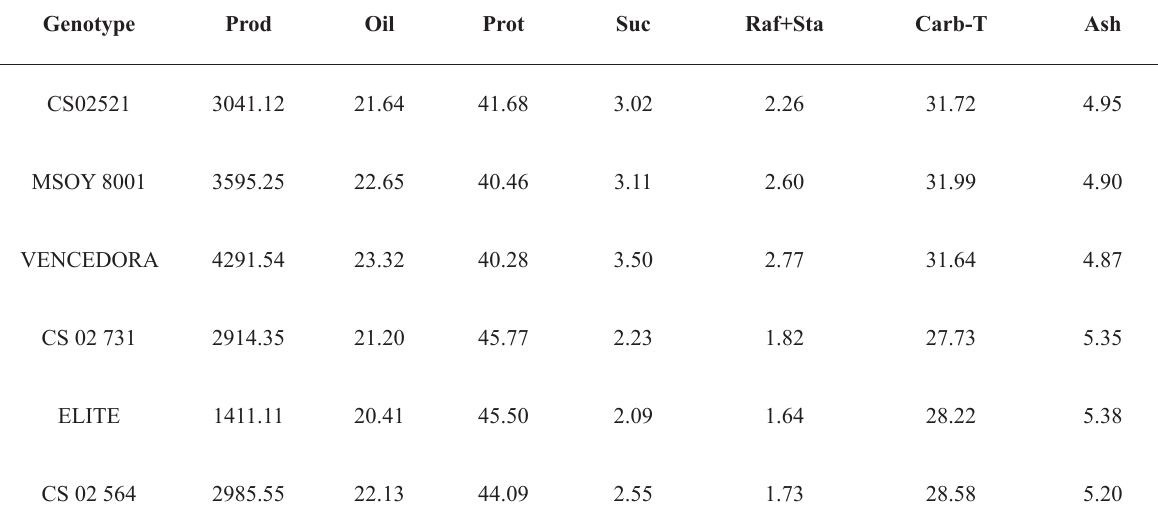
Mean values were obtained in triplicate for each sample.